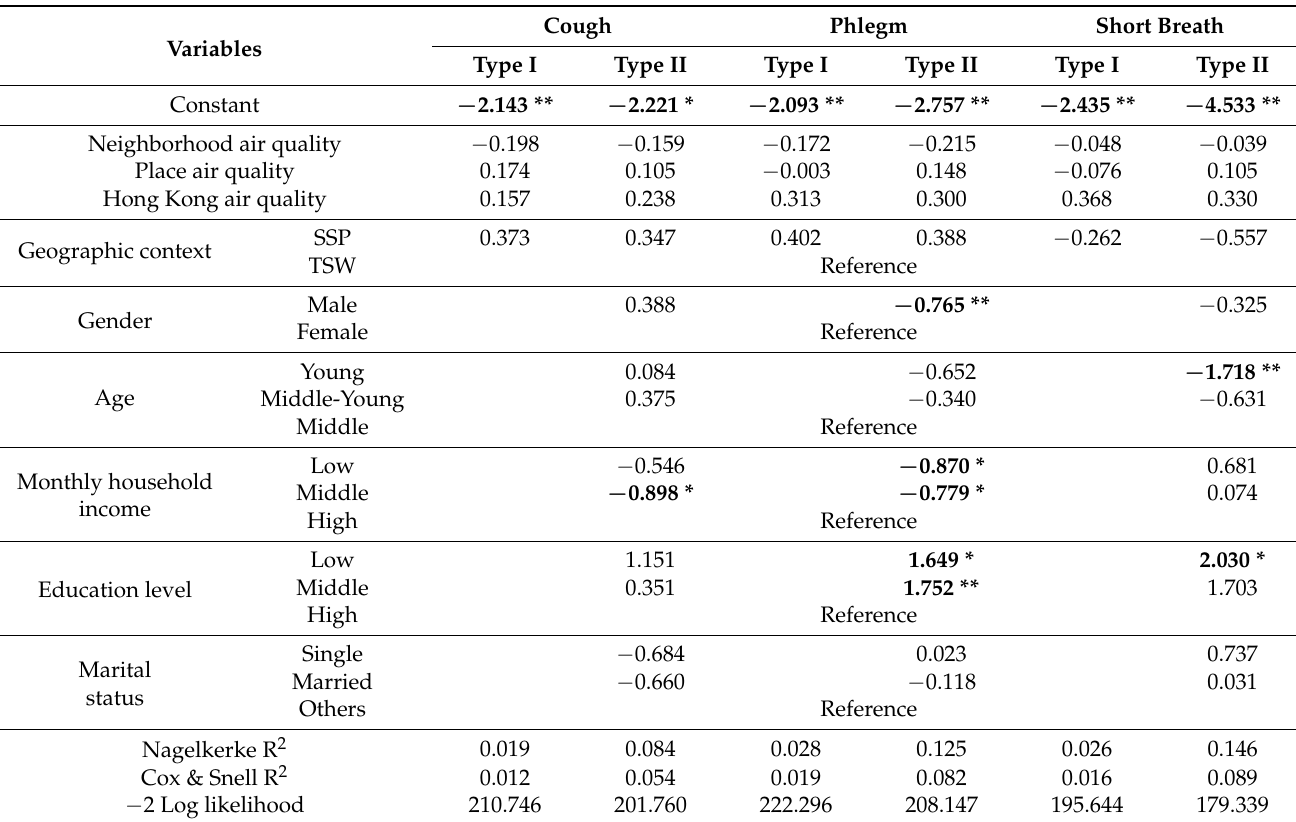
Table 8. Results of the binary logistic regression models for predicting participants’ self-reported frequency of respiratory symptoms in SSP and TSW, N =